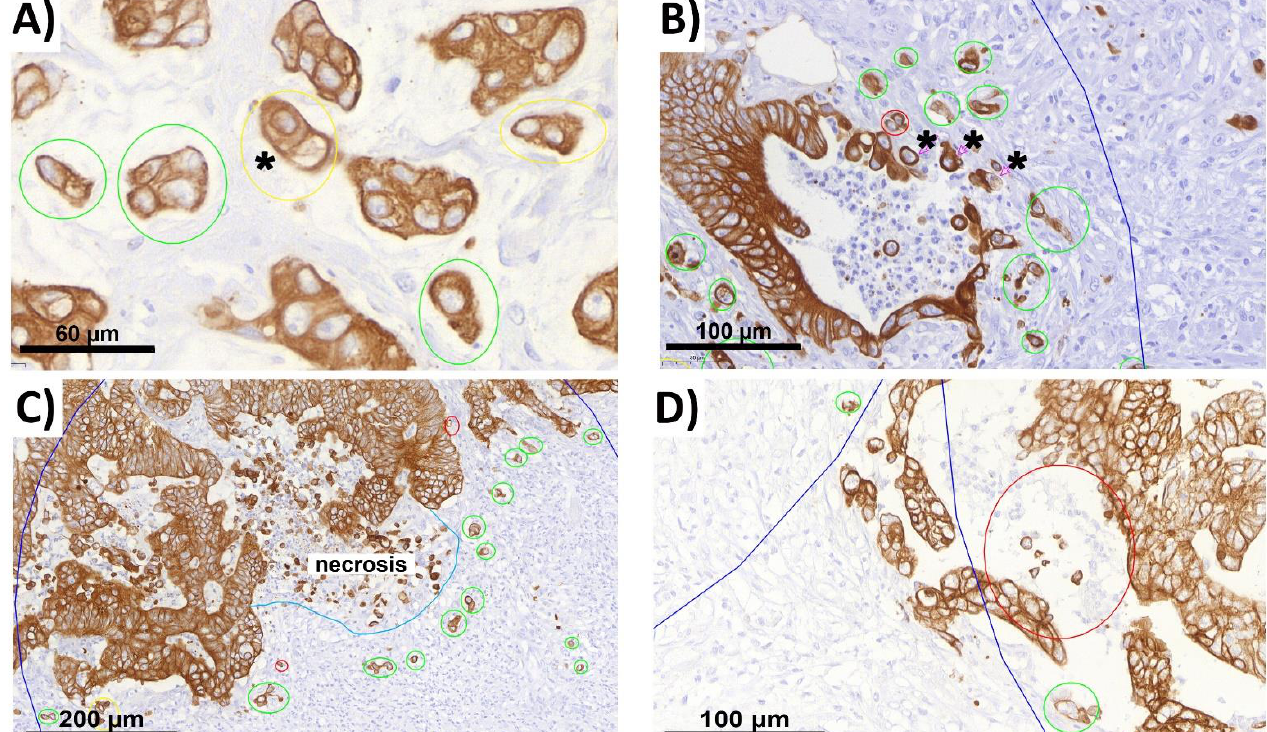
Figure 2. Budding analysis depending on cell environment ( A – D ). For technical data, see legend in Figure 1. ( A ) Distance between cells: the distances between the questionable bud (*) and the tumor cell group next to it is shorter than the average diameter of the cells of these two. The questionable bud is therefore considered as a unit with the tumor cell group next to it. A group of more than 4 cells is formed and thus is not considered a bud. Magnification: 78.8 × . ( B ) Ruptured gland with comedonecrosis: the marked cells (*) are too close to the comedonecrosis, which is why they cannot be considered buds that are part of the necrosis. The cells marked in green are not associated with comedonecrosis and are considered buds. Magnification: 37.4 × . ( C ) Necrosis border: the border of necrosis is marked in blue. No tumor cells in this area can be considered buds. All cells marked in green are sufficiently far away from this area, so they are considered buds. Magnification: 18.0 × . ( D ) Intraluminal location: the cells marked in red are located in the lumen of the gland and, therefore, cannot be considered buds. Buds have to be located extraluminally in the connective tissue. Magnification: 38.9 × .